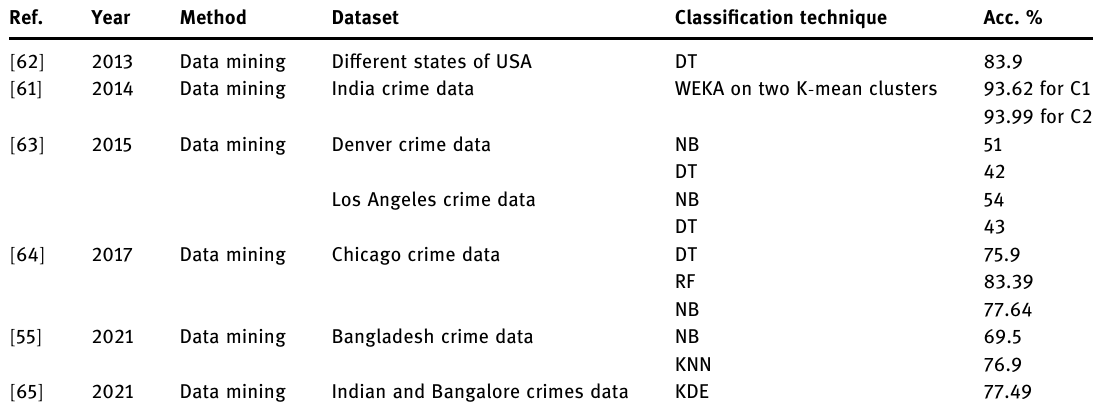
Table 3: Literature survey on crime prediction research works with data mining